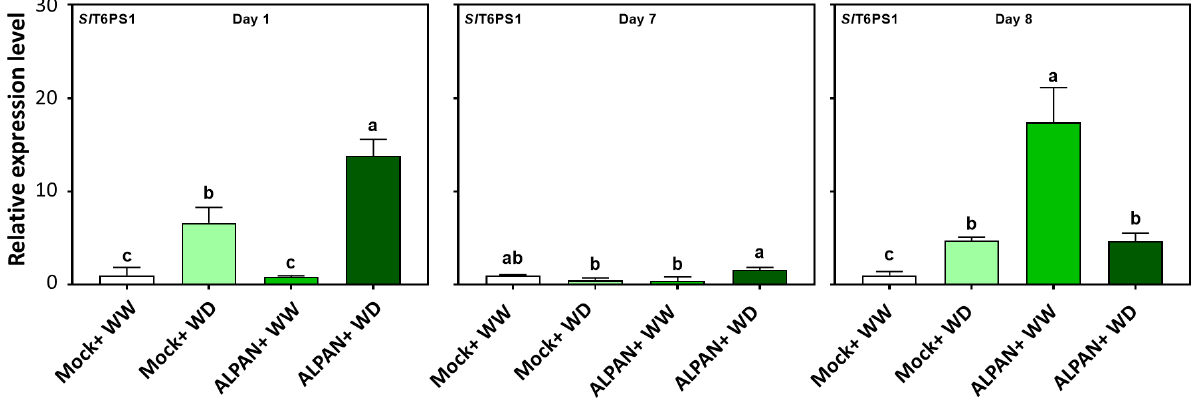
Figure 8. Expression levels of SlT6PS1 after 1, 7, and 8 days of the initiation of the water deficit stress. WW = well watered, WD = water deficit. Error bars above histogram columns represent the standard deviation of four independent biological replicates in each experimental group at each sampling timepoint. The statistical data were analyzed with the use of the one-way ANOVA and Tukey’s post hoc tests, and a statistically significant difference ( p -value < 0.05) is denoted by a different letter above a histogram column.